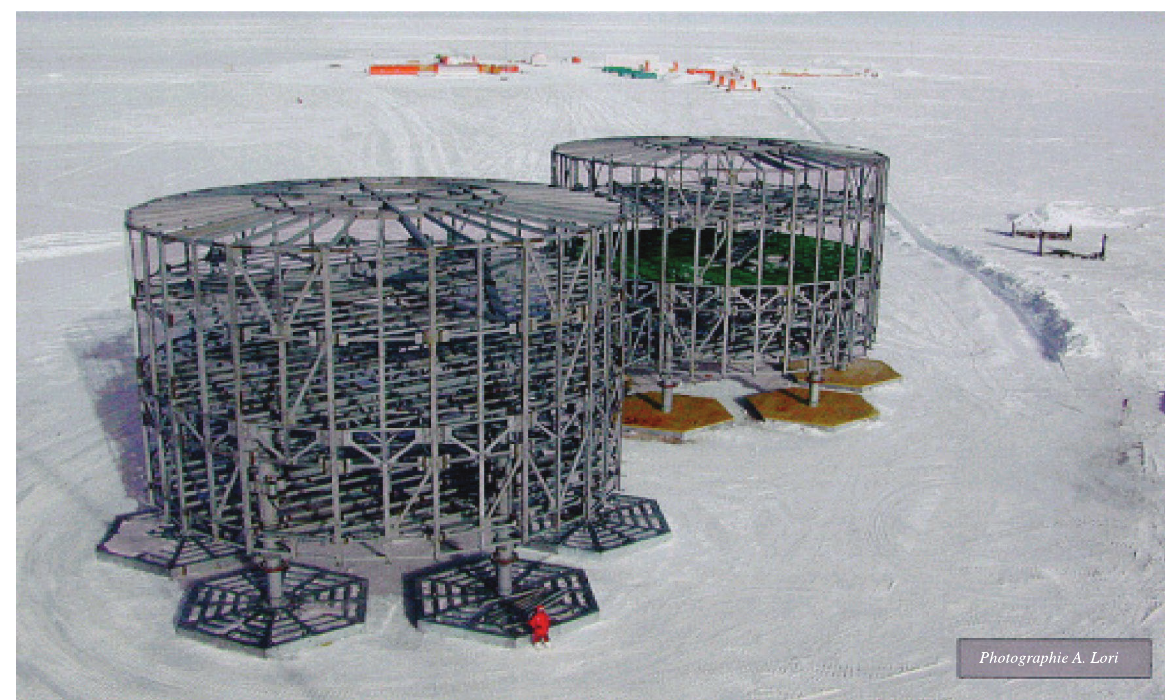
Fig. 5. The Continental Base Dome-C (work in